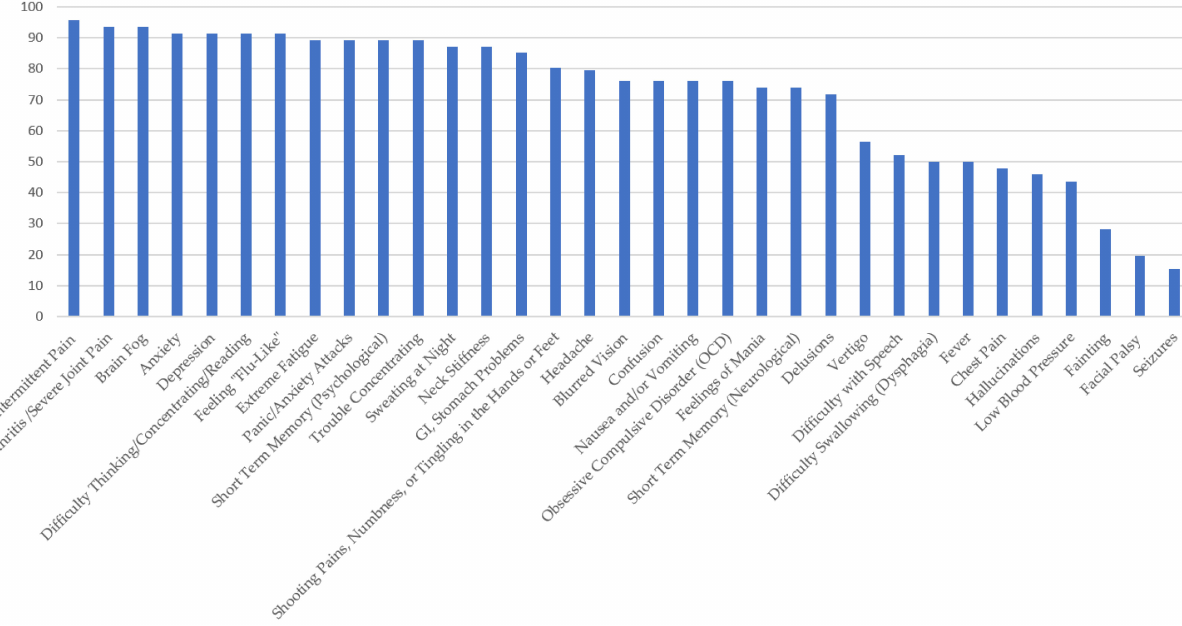
Figure 2. Percentage of Respondents with Babesiosis Reporting Specific Symptoms.